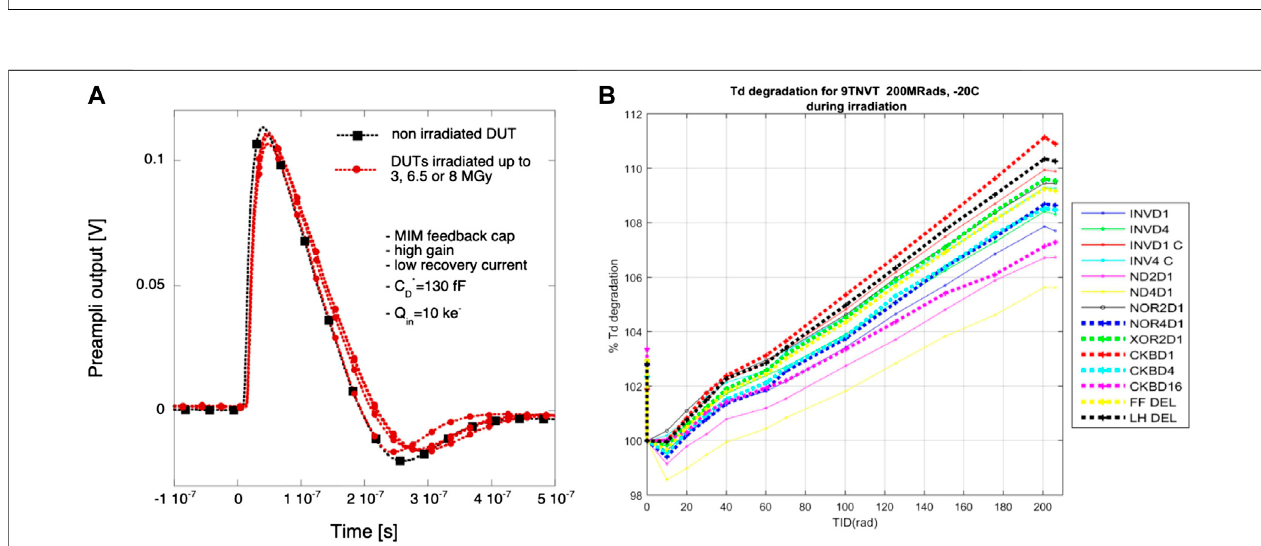
FIGURE3|(A) Shapeatdifferenttotaldoseirradiation forapreampli fi erfroma50x50 μ m 2 pixelcell,from[24]; (B) Timingvariationfordifferentelements of65 nm digital library from [25].